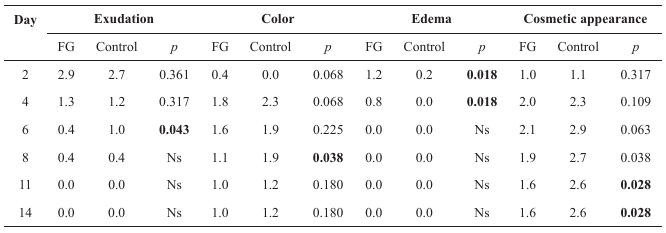
TABLE 2 - Average scores for the clinical evaluation of the FG group (control versus fibrin glue).